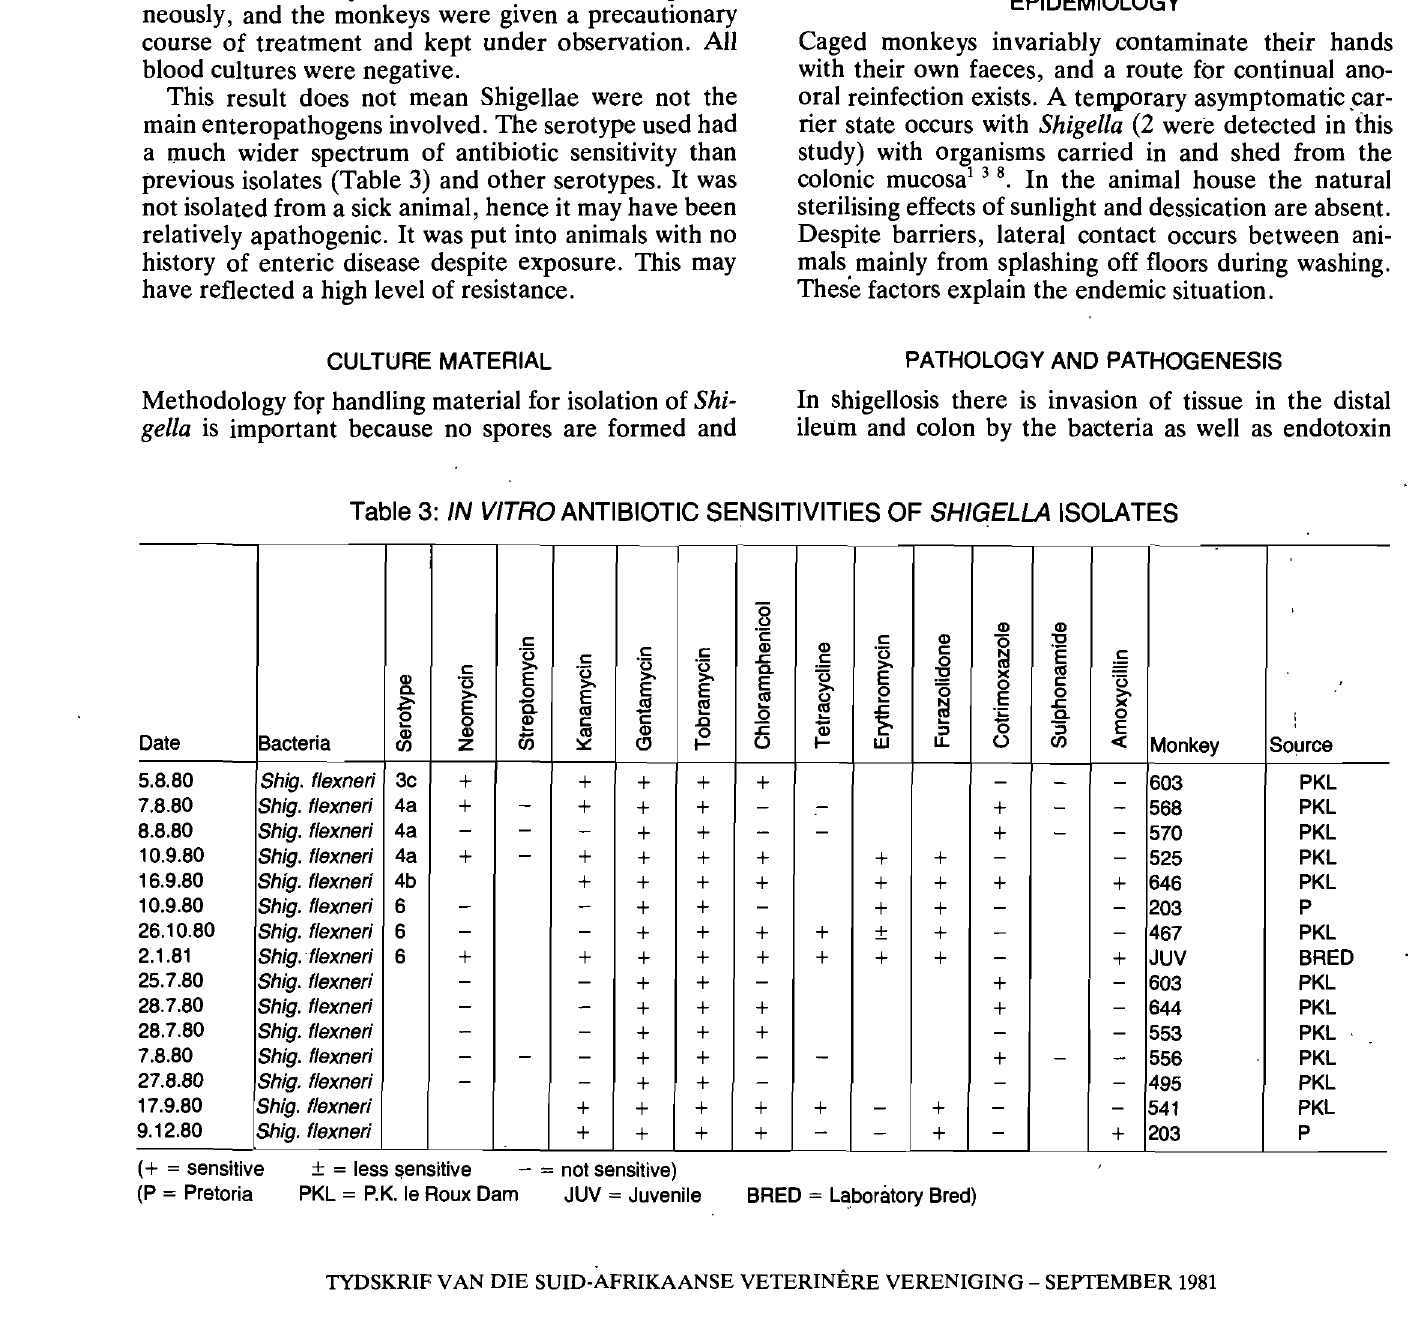
Table 3: IN VITRO ANTIBIOTIC SENSITIVITIES OF SHIGELLA